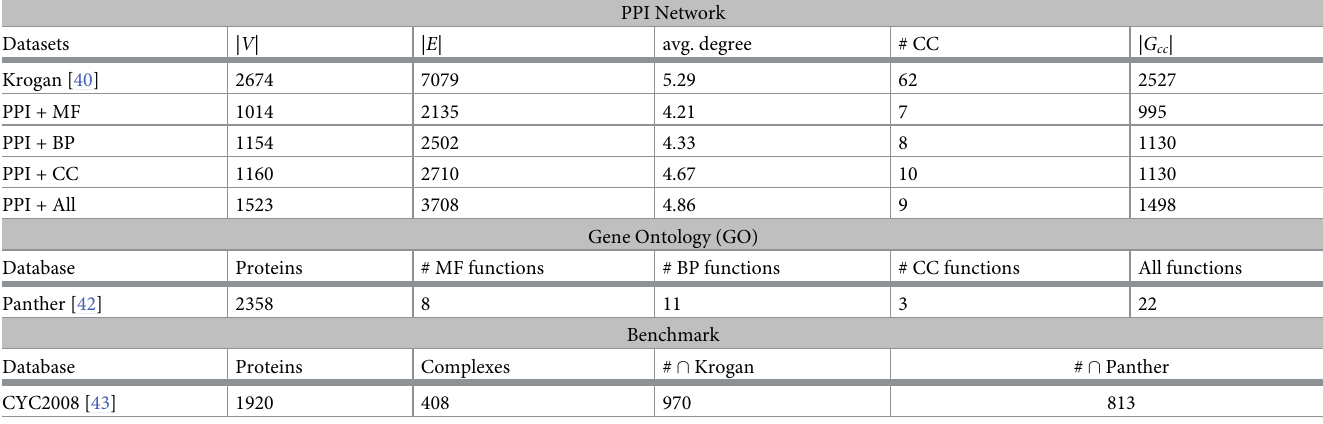
Table 2. Datasets of networks used for the experiments.